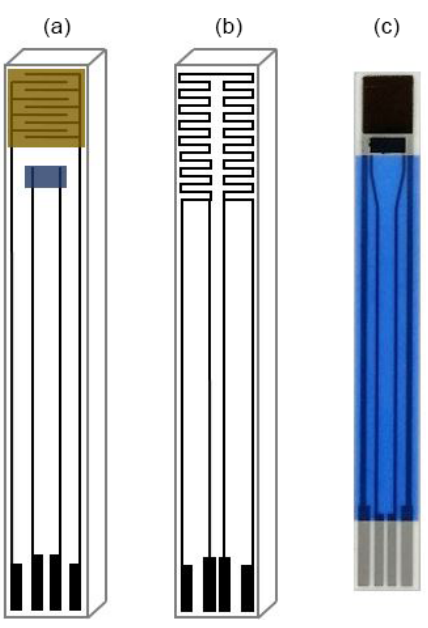
Figure 1. Scheme of the sensor setup ( a : sensing side, b : reverse side of the sensor with heating element); image of the sensing side (c)